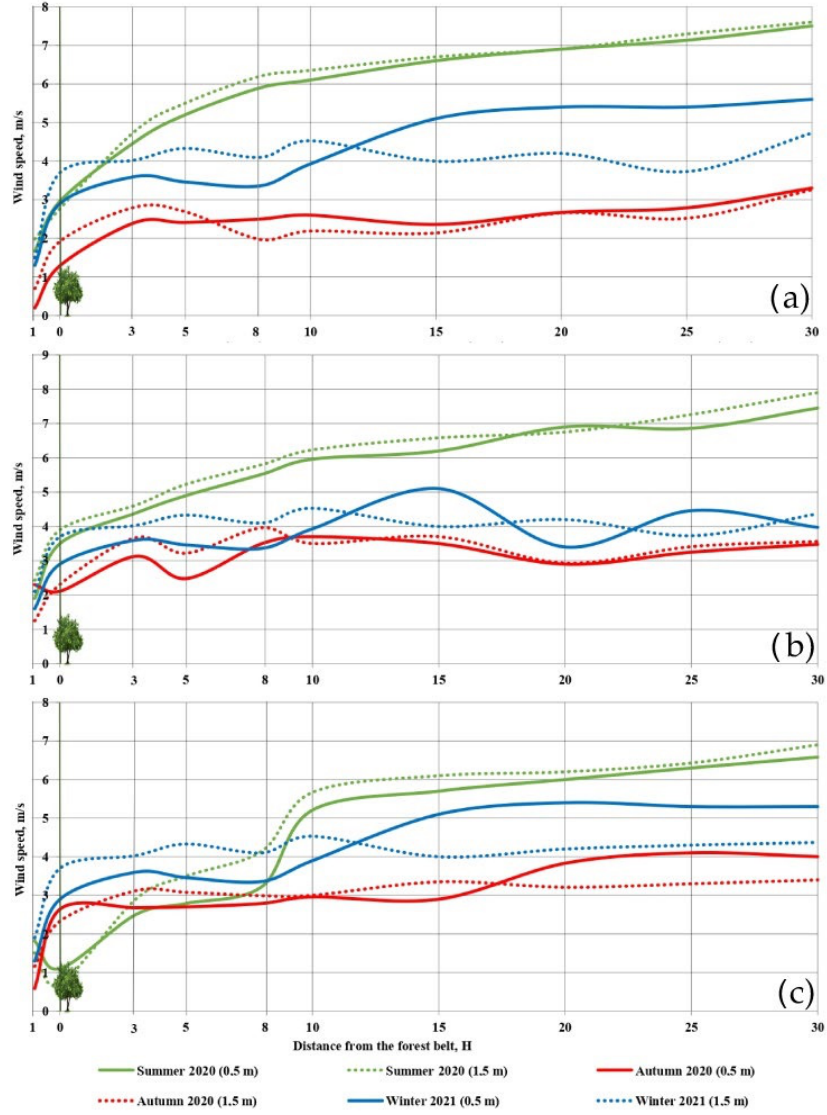
Figure 9. Wind speed in ( a ) the morning, ( b ) the afternoon, ( c ) and the evening. In the afternoon in summer, there is also a “classical” impact of the forest belt at both studied altitudes, which can be traced up to 25–30H. Thus, the wind speed at a distance of 3H is 4.3 m/s and 4.6 m/s, respectively, and at a distance of 30H 7.5 m/s and 7.9 m/s, respectively. In autumn, the impact can be traced up to the distance of 8H at 0.5 m, and up to the distance of 10H at 1.5 m. In winter, the impact of the forest belt on the wind speed is not traced. Thus, the difference between the values of wind speed at the altitudes of 0.5 and 1.5 m and the distances of 3H and at 30H is 0.3 m/s. In summer, in the evening time, the impact of the forest belt on the wind speed at the two studied altitudes is monitored up to a distance of 8–10H. The wind speed at the altitudes of 0.5 m and 1.5 m is 2.5 m/s and 2.9 m/s at 3H, respectively, and 6.6 m/s and 6.9 m/s at 30H, respectively. In autumn, at 0.5 m and 1.5 m, the impact of the forest belt on wind speed is on average up to a distance of 3H, and in winter—up to